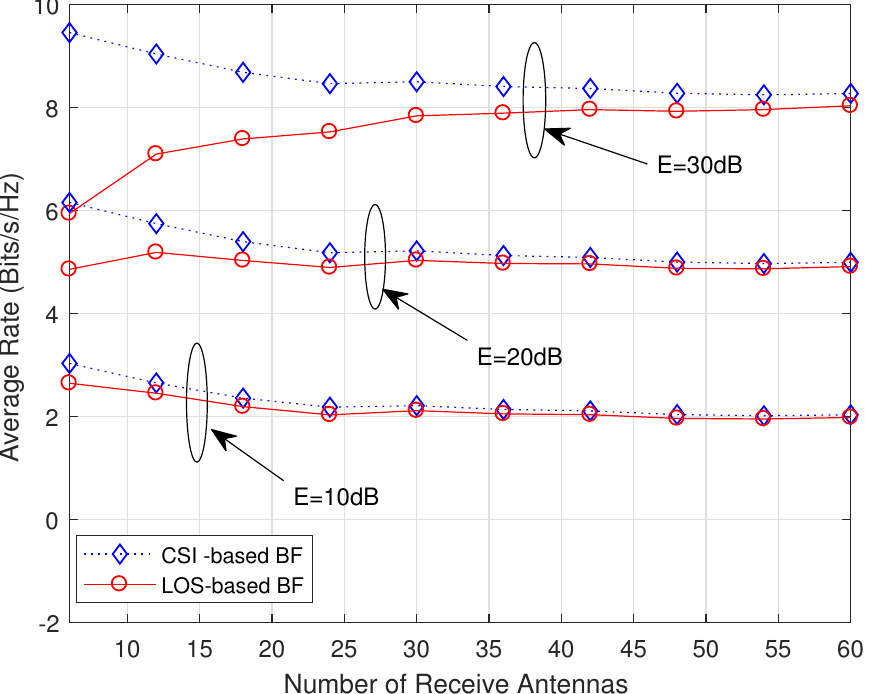
Figure 2. The ergodic achievable rate versus the number of receive antennas for comparing the LOS-based scheme with the whole CSI-based